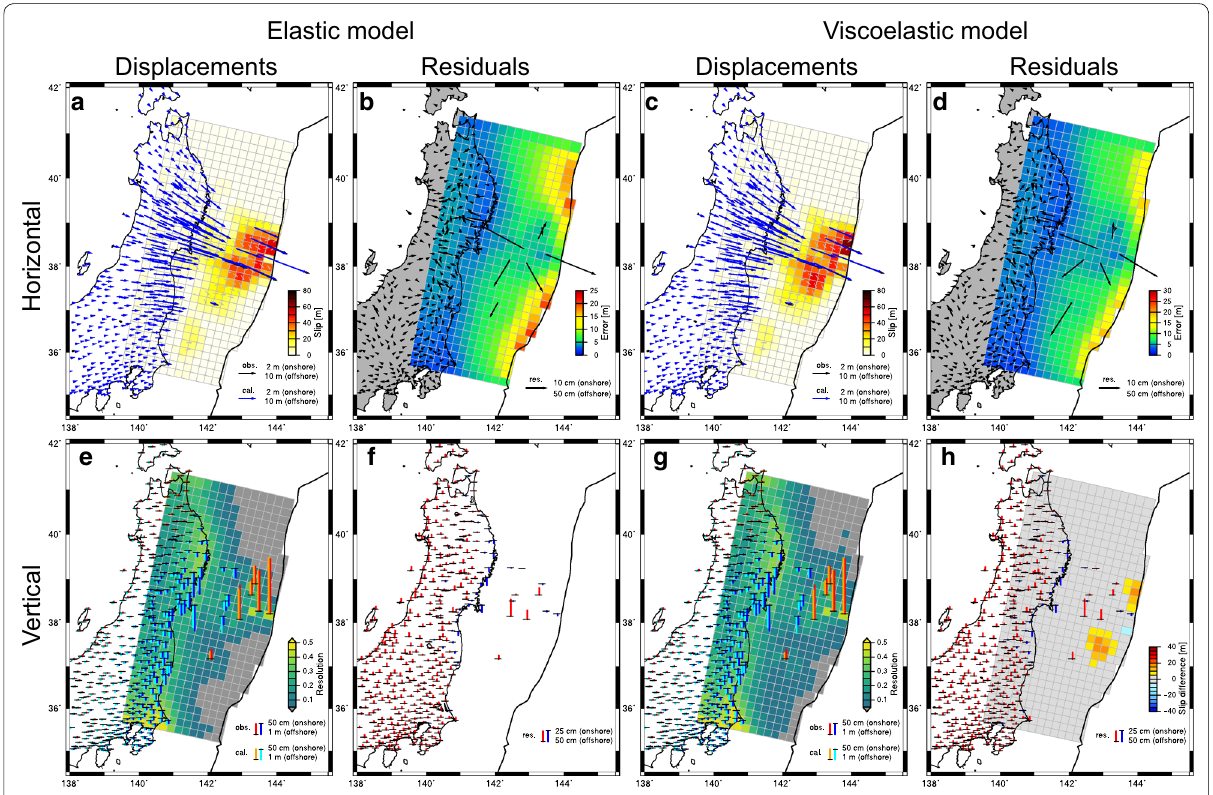
Fig. 12 Coseismic slip models estimated by the elastic and viscoelastic inversions. Coseismic displacements and misfits in the elastic model ( a , b , e , f ) and the viscoelastic model ( c , d , g , h ) are shown in each panel. In a and c , black and blue vectors show the observed and calculated horizontal displacements, respectively. In b and d , black vectors show misfits between the observed and calculated horizontal displacements. In e and g , red and blue bars show the observed uplift and subsidence, while magenta and cyan bars show the calculated uplift and subsidence, respectively. In f and h , red and blue bars show misfits in the uplift and subsidence components, respectively. Colors of sub-faults in a and c , in b and d , in e and g , and in h show coseismic slip, 1σ estimation errors, resolution, and difference of coseismic slip between the elastic and the viscoelastic models, respectively. Small vectors in a and c represent slip directions on patches with estimated slip over 2σ